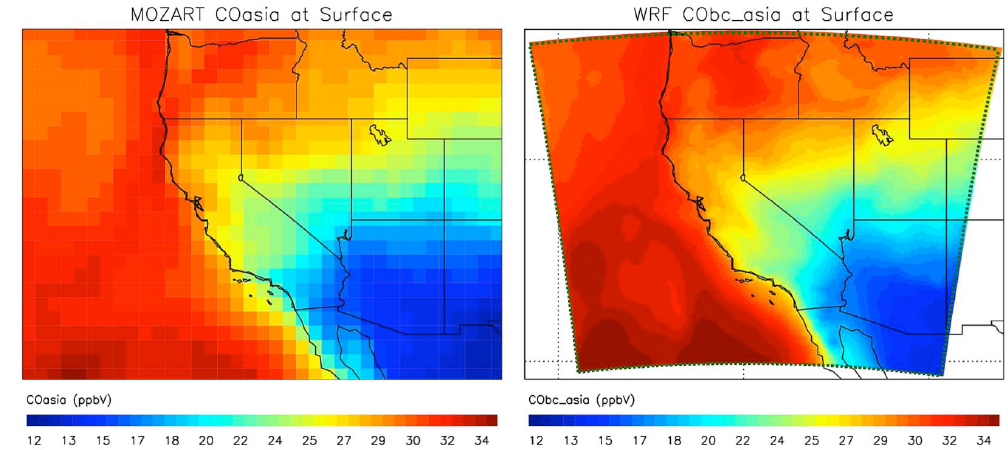
Fig. 11. Average COasia surface mixing ratios (ppbV) from MOZART-4 (left) and WRF-Chem for 20 June–15 July.